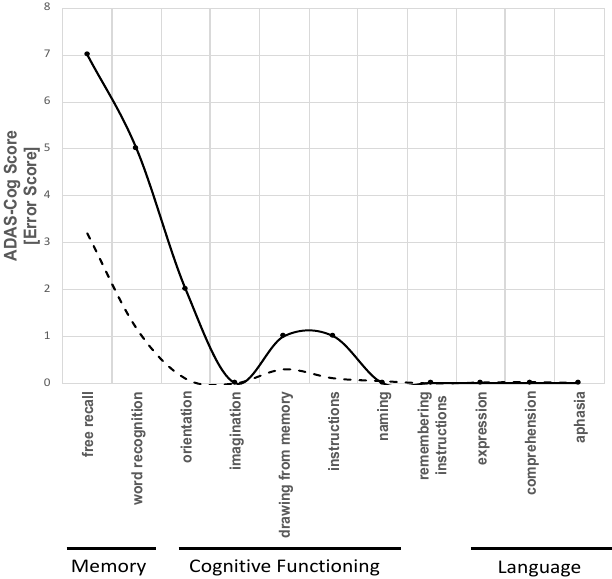
Figure 2. Example of a patient’s cognitive profile of the Alzheimer’s Disease Assessment Scale – Cognition (ADAS-Cog) with mild to moderate dementia from a patient included in the IMAD trial (own figure). Continuous line, cognitive profile with mild to moderate dementia; dashed line, cognitive profile with no cognitive impairment; grey area, 95% confidence interval for the cognitive profile. Without impairment according to Graham, Emery and Hodges [48].